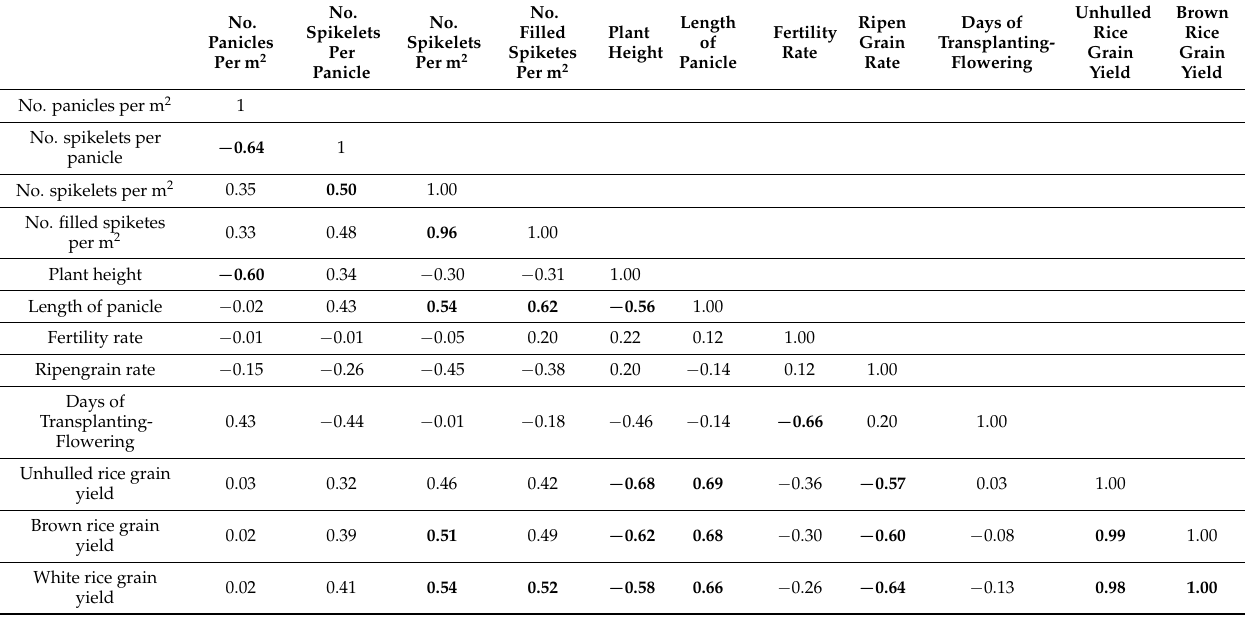
Table 5. Correlations of morphological variables with yield for all eight cultivars used in this study (numbers are shown in bold when correlation is significant. Correlation coefficients between 0.5 and 0.7 indicate moderate correlation between variables, while correlation coefficients between 0.3 and 0.5 indicated variables with weak correlation. Numbers are shown in bold when the absolute values are over